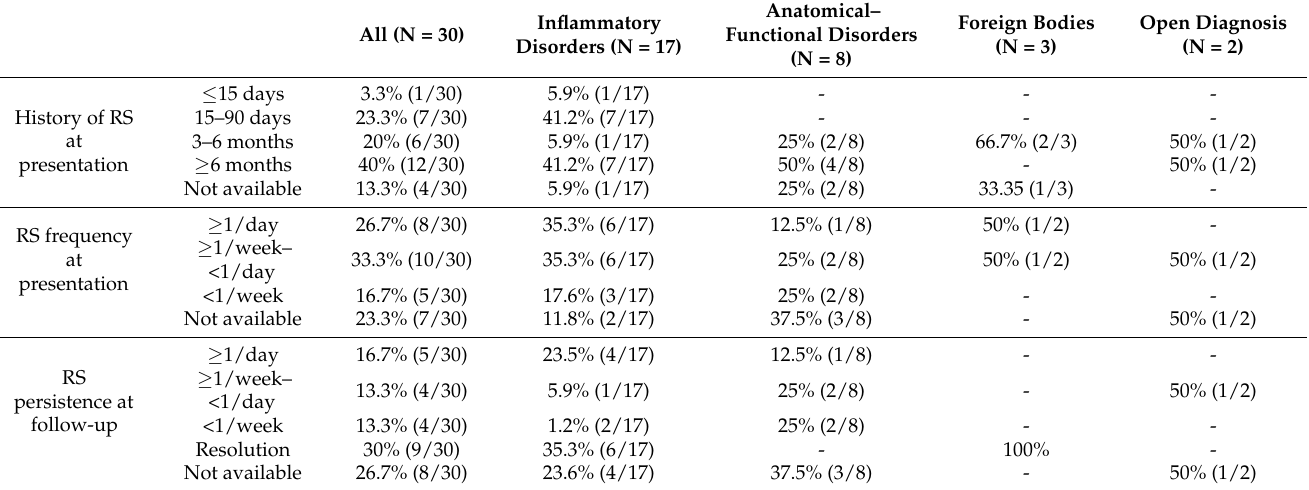
Table 2. A breakdown of reverse sneezing (RS) characteristics by the different diagnosis